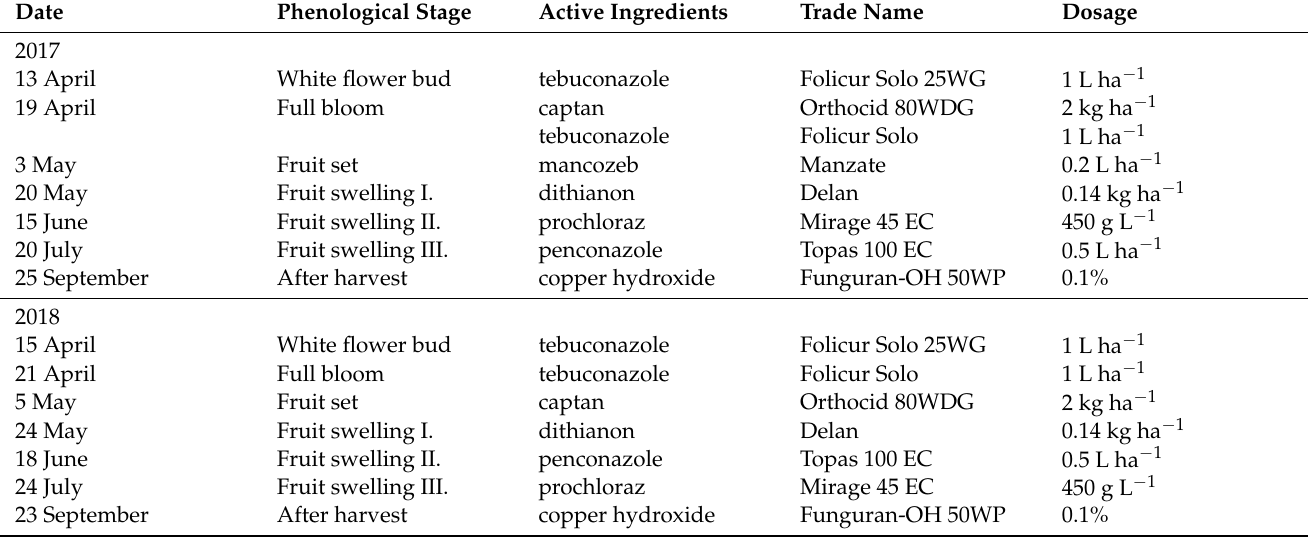
Table 2. Fungicide spray programmes against shot hole disease on four plum cultivars (‘ ˇCaˇcanska lepotica’, ‘Bluefre’, ‘Stanley’ and ‘President’) in four training systems (4 × 1.5, 4 × 2, 5 × 2.5 and 6 × 3 m) in an integrated plum orchard at Debrecen-Pallag, East Hungary